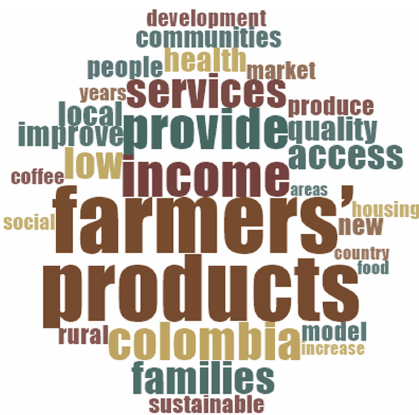
Figure 1. Word cloud for the 30 most commonly used